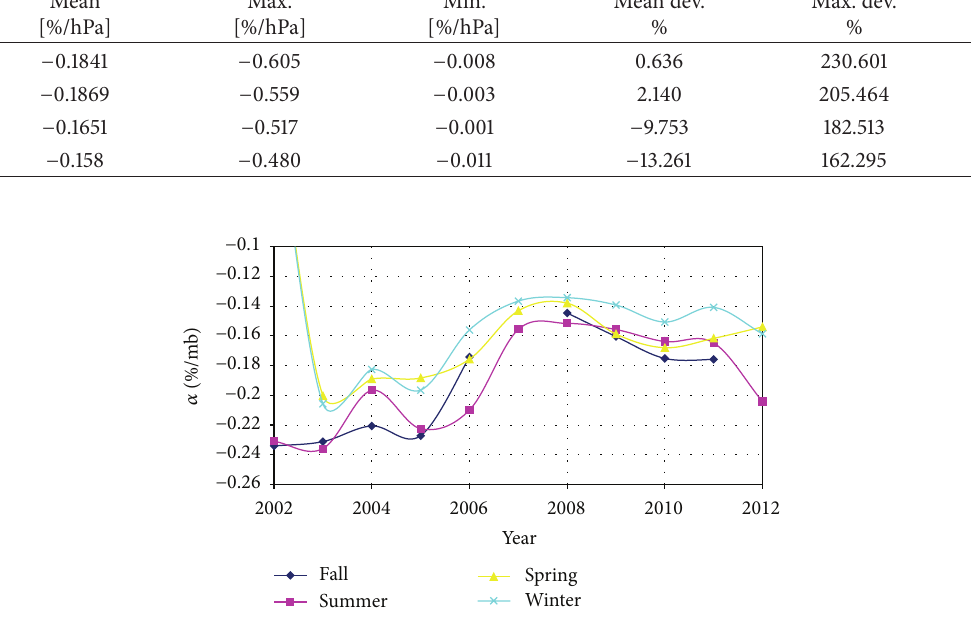
Figure 6: Time series of interannual variation of 𝛼 [%/hPa] for the four seasons.